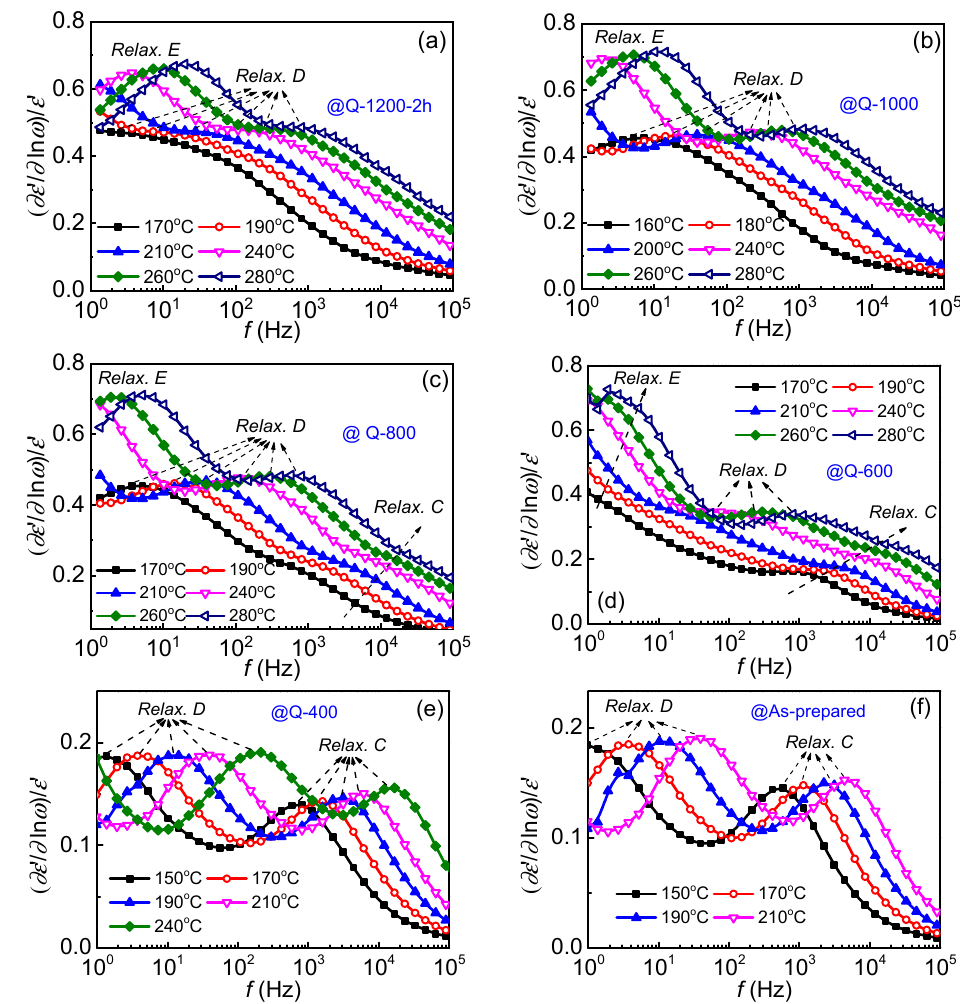
Figure 6. Dielectric spectra ( ∂ ε′ / ∂ ln ω )/ ε′ at elevated temperatures of Q-1200-2h ( a ), Q-1000 ( b ), Q-800 ( c ), Q-600 ( d ), Q-400 ( e ) and as-prepared samples ( f